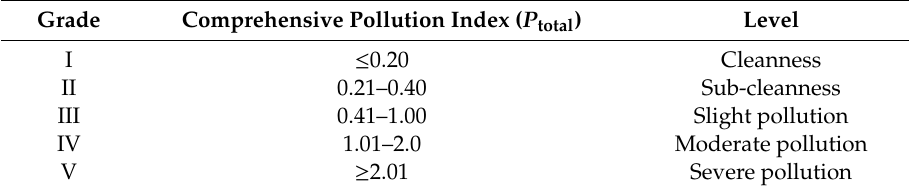
Table 2. Grading standard for water quality